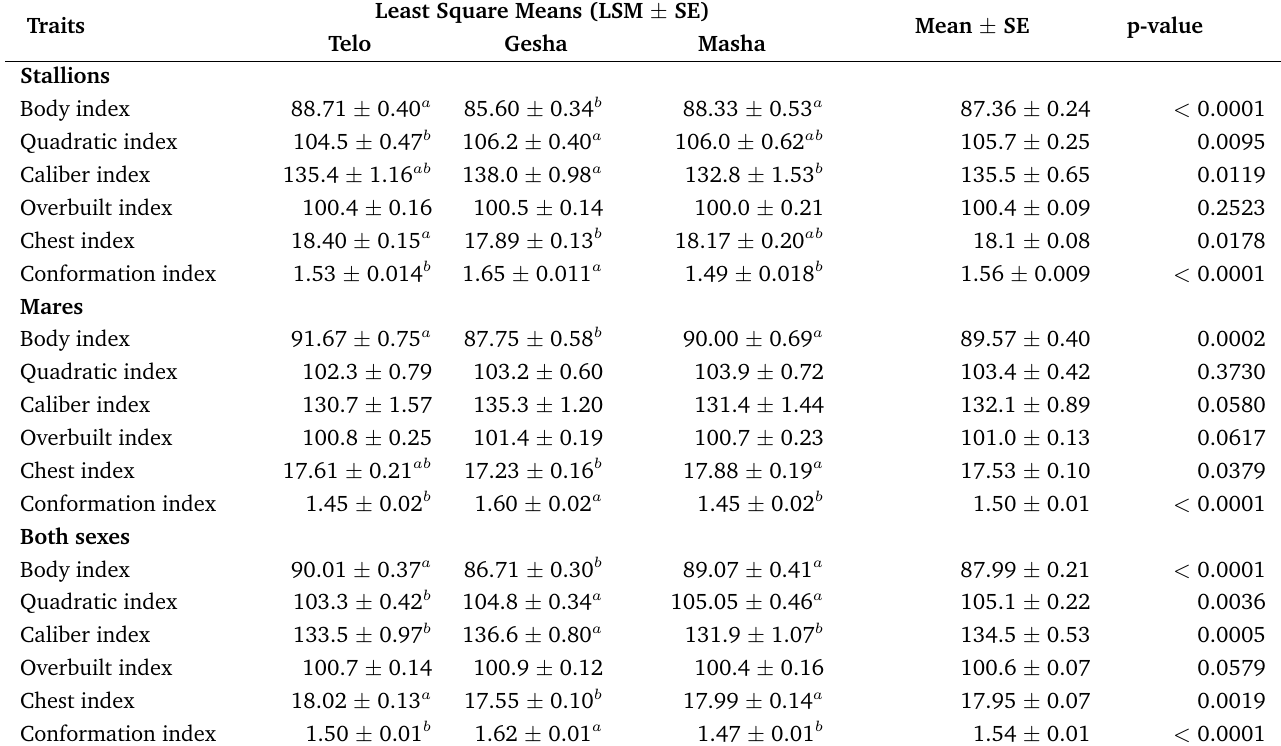
Table 8. Body measure indices of the studied horse